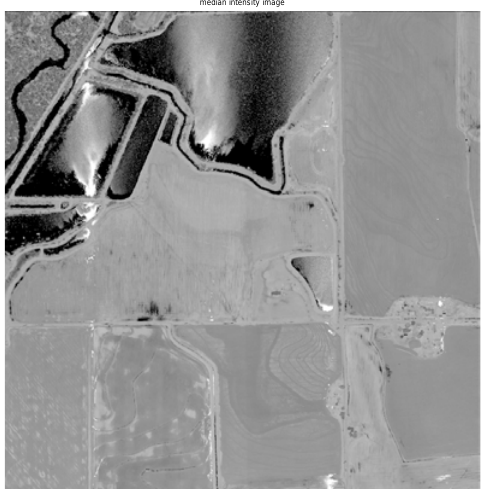
Figure 3. 2m pixel intensity image in log